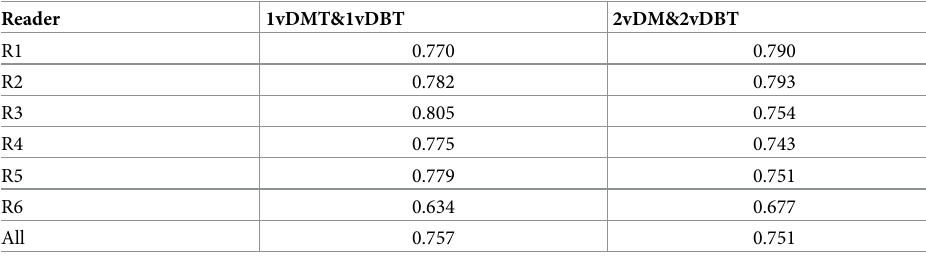
Table 4. JAFROC figure of merit (FoM) per reader and on